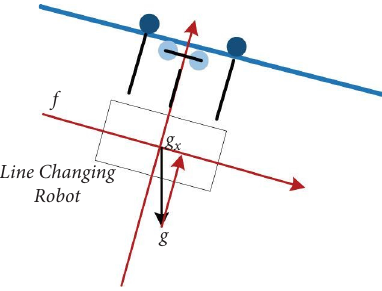
Figure 2: Force analysis of the wire dismantling robot.